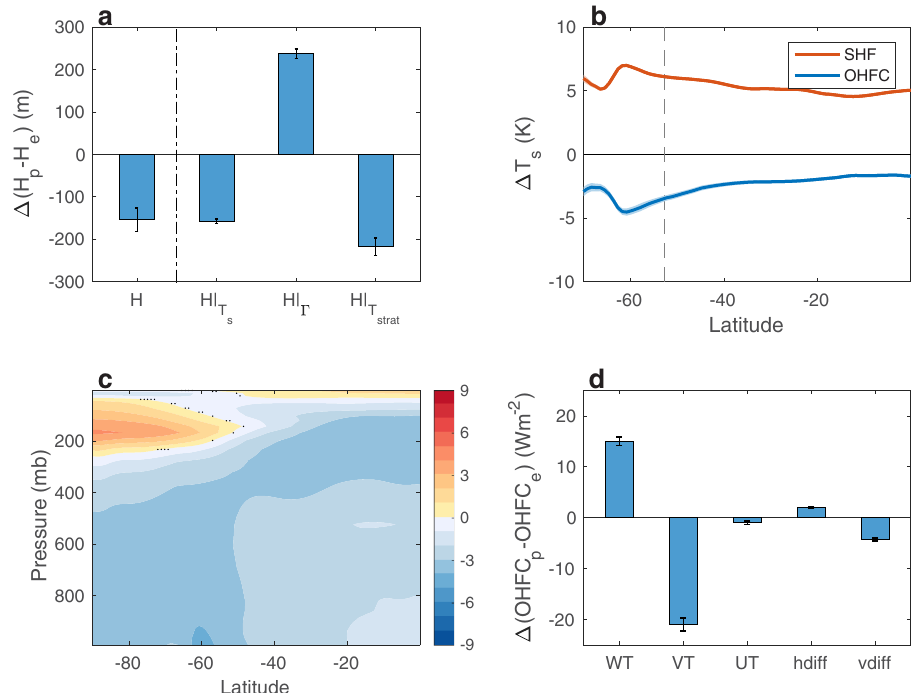
Fig. 4 The contribution of dynamic coupling to the response of the tropopause height. a The effect of dynamic coupling on the response to anthropogenic emissions of the tropopause height on the poleward fl ank of the eddy kinetic energy (EKE), relative to the equatorward fl ank ( Δ ( H p − H e ), m), and the relative contributions to Δ ( H p − H e ) from surface temperature ( H j T ), tropospheric lapse rate ( H ∣ Γ ) and stratospheric s temperature ( H j T ). b the effect of thermodynamic (red) and dynamic (blue) coupling on the response of the surface temperature (K) to anthropogenic strat emissions. Shading shows two standard deviations across the ensemble members, and the vertical dashed line shows the climatological position of the storm tracks. c The effect of dynamic coupling on the response of atmospheric temperature (K) to anthropogenic emissions. Black dots show where the response is not statistically signi fi cant at the 5% level based on a Student ’ s t-test. d The response to anthropogenic emissions of the different components of mixed-layer ocean heat fl ux convergence (OHFC) on the poleward fl ank of the EKE, relative to the equatorward fl ank ( Δ (OHFC p − OHFC e ), Wm − 2 ); vertical ( WT ), meridional ( VT ) and zonal ( UT ) heat fl ux, and horizontal (hdiff) and vertical (vdiff) heat diffusion. The error bars show the 95% con fi dence interval based on a Student ’ s To better understand how thermodynamic coupling modulates coupling produces the upper tropical tropospheric warming (by the vertical shear of the zonal wind, and thus the EKE position, I modulating the moist adiabatic lapse rate) and lower strato- next explore the effects of thermodynamic coupling on the spheric cooling at high latitudes. These temperature changes meridional temperature gradient, which is in balance with the increase the upper-level meridional temperature gradient zonal wind shear. Thermodynamic coupling accounts for most of (together with the zonal wind shear), on the poleward fl ank of the global warming temperature pattern (Fig. 3b): by warming the the jet, which pushes the baroclinicity and thus the EKE surface through all latitudes (red line in Fig. 4b) thermodynamic poleward; similar effect of global surface warming was found in